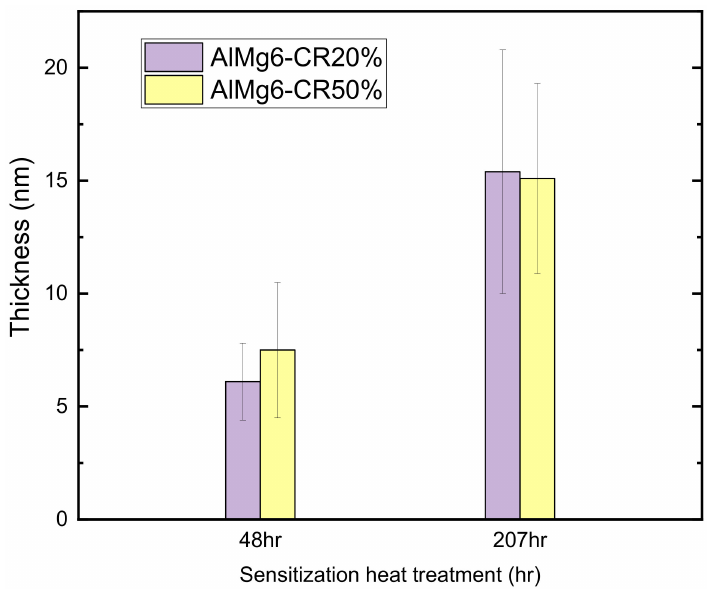
Figure 12. Thickness of β -phase precipitates in the CR20, and CR50 alloys sensitized for 48 and 207 h,